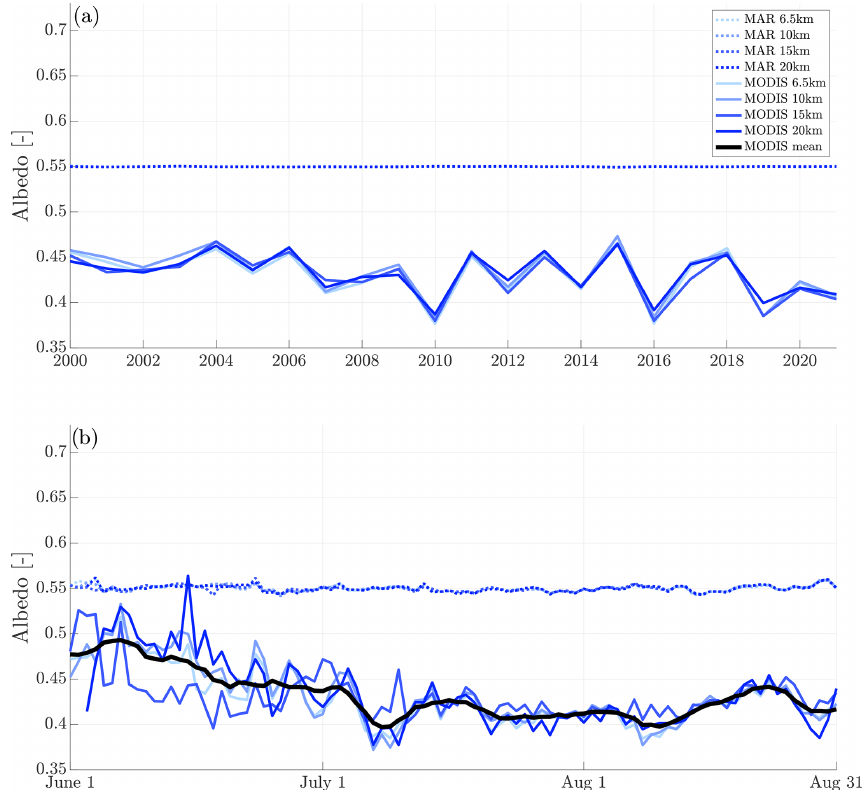
Figure 5. (a) Annual bare-ice albedo in 2000–2021, averaged over JJA, and (b) seasonal bare-ice albedo in JJA, averaged over